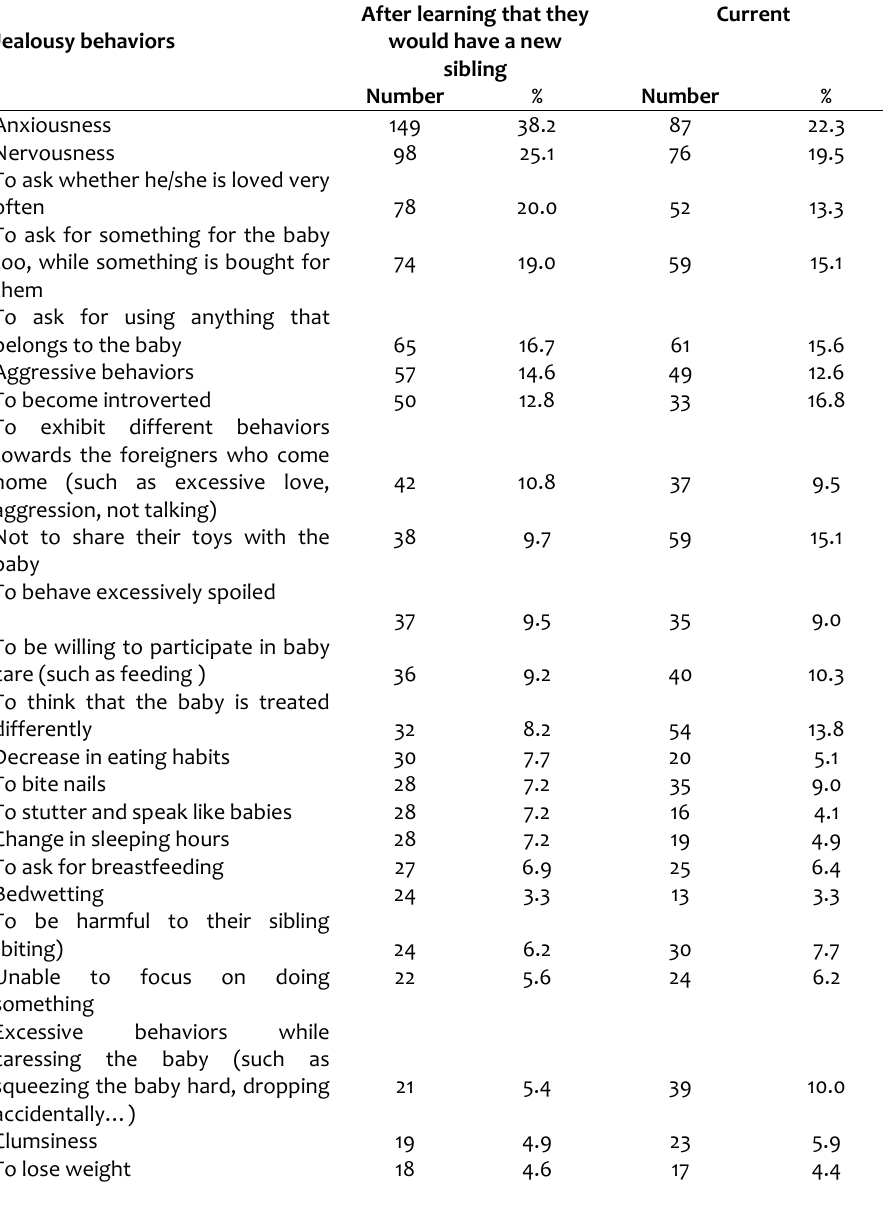
Table 4 . The distribution of children’s current jealousy behaviors and after learning that they would have a new